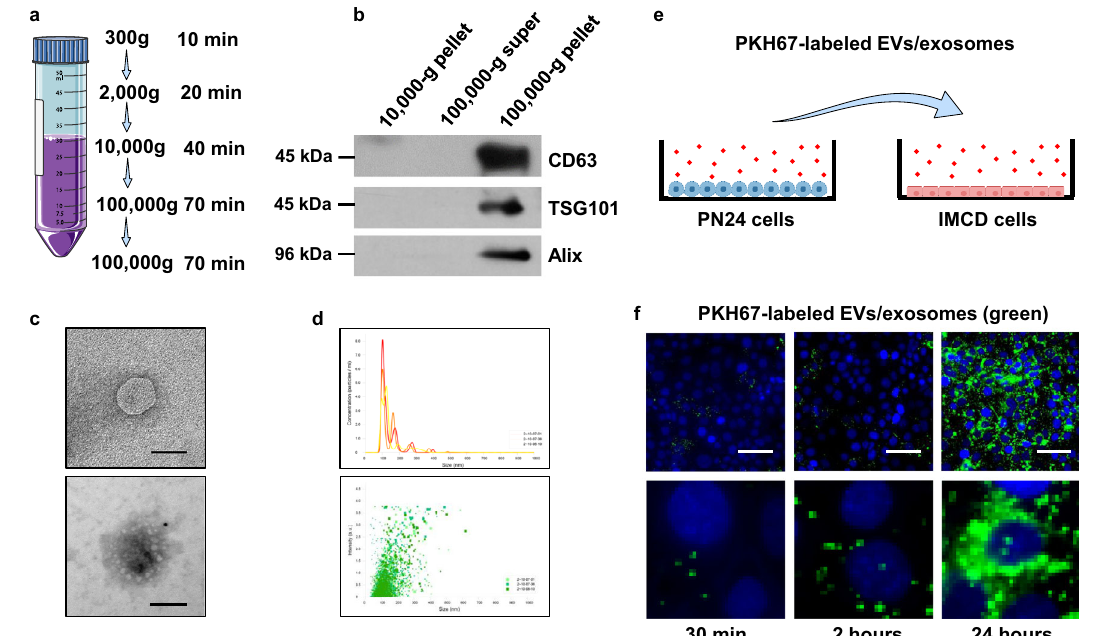
Fig. 1 Pkd1 -null renal epithelial cell-derived EVs/exosomes can be taken by recipient cells. a Protocol of the EVs/exosome isolation and puri fi cation from FBS-free media. b Western blot analysis of the 10,000-g pellet, 100,000-g supernatant, and 100,000-g pellet from FBS-free media by sequential centrifugation. The CD63, TSG101, and Alix proteins, markers of exosomes, were abundant in the 100,000-g pellet isolated from FBS-free media. c Transmission electron microscopy (TEM) of EVs/exosomes in FBS-free media (top panel) and Immunogold labeled exosomes (bottom panel). Scale bars, 100nm. d EVs/exosome detection by nanoparticle-tracking analysis (NTA) in FBS-free media. The most often particle diameter is on average of 109.8nm (top panel), and the distribution histogram showed that the particle diameters were concentrated in the range of 100 – 110nm (bottom panel). e Schematic of EVs/exosome uptake experiment. Puri fi ed PN24 cell-derived EVs/exosomes were labeled with green fl uorescent dye, PKH67, and incubated with mouse IMCD3 cells. f Mouse IMCD3 cells were incubated with PKH67-labeled (green) EVs/exosomes from PN24 cells for 30min, 2h, and 24h, and fi xed for immuno fl uorescence imaging. Scale bars, 100 μ